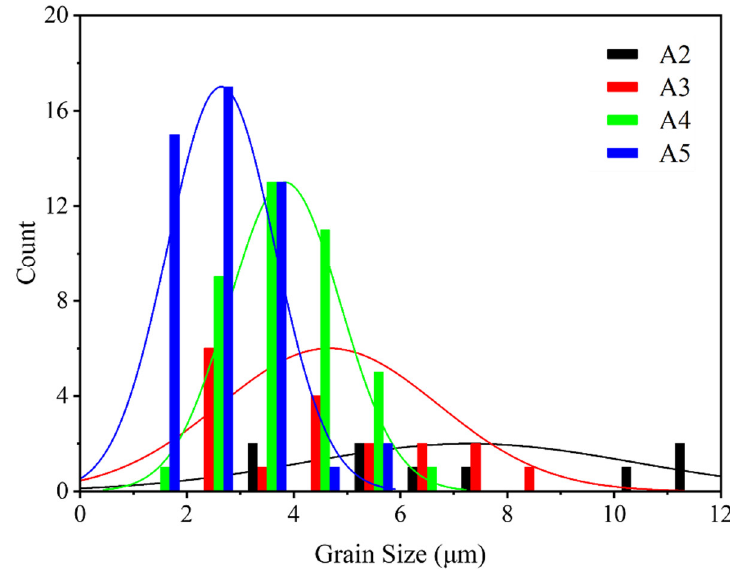
Figure 5. Relationship between Cr 2 O 3 content and the average grain size of Fe(Fe,Cr) 2 O 4 in Figure 2c–f.